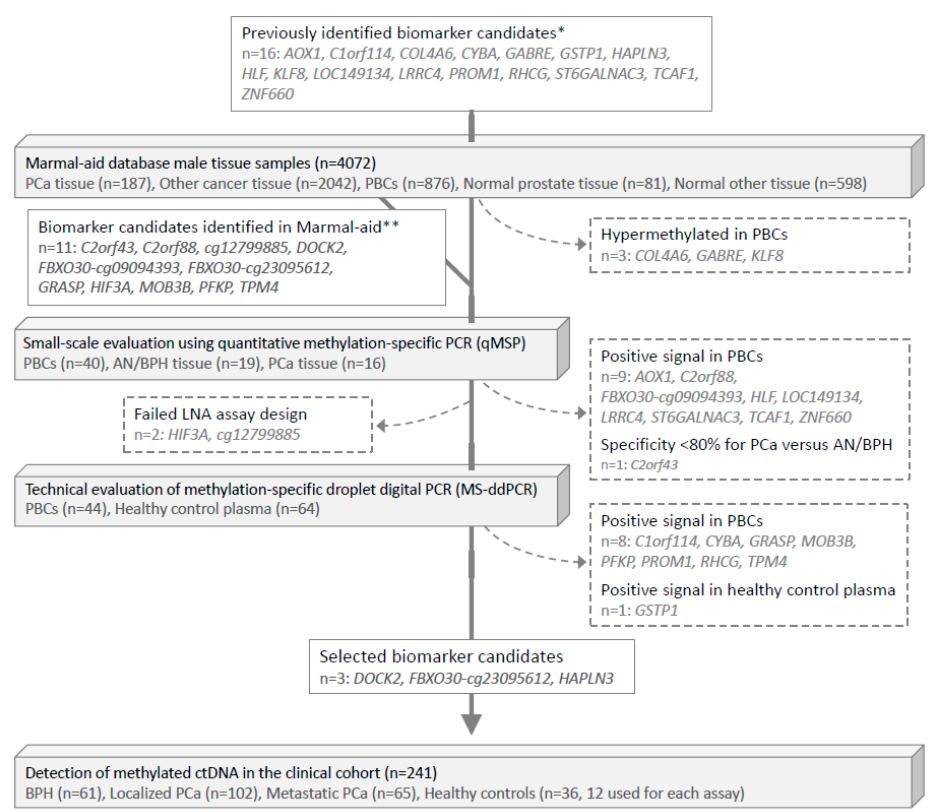
Figure 1. Flowchart of biomarker selection and validation. PCa, prostate cancer. PBCs, peripheral blood cells. AN, adjacent normal. BPH, benign prostatic hyperplasia. * Biomarker candidates were identified in the following previous studies: Strand et al. [12] ( COL4A6, CYBA, HLF, LOC149113, LRRC4, PROM1, RHCG, TCAF1 ); Haldrup et al . [10] ( AOX1, C1orf114, HAPLN3, KLF, ST6GALNAC3,